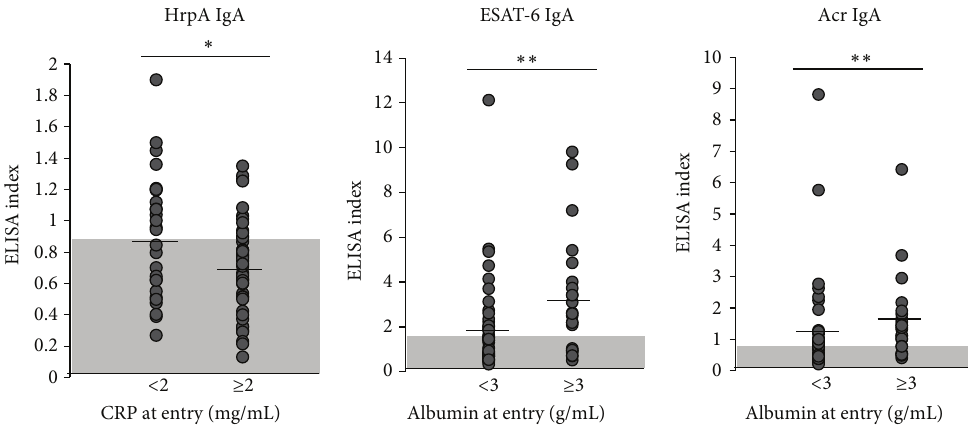
Figure 5: Association between immunological scores and clinical scores. HrpA IgA was negatively associated with “CRP at entry.” ESAT-6 IgA and Acr IgA were positively associated with “Albumin at entry.” Shaded areas: areas under cut-off values, vertical lines: mean values. ∗ 𝑃 < 0.05 , ∗∗ 𝑃 < 0.01 .